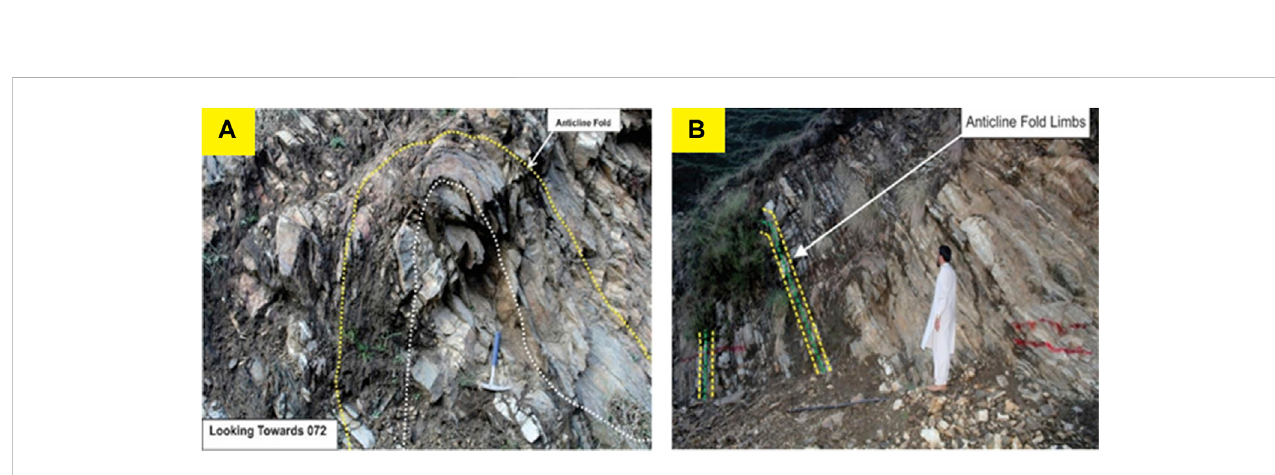
FIGURE 14 (A) Anticline fold looking toward 072 ° and (B) anticline fold that has a dominant lithology of gneiss. The limbs are not completely exposed due to